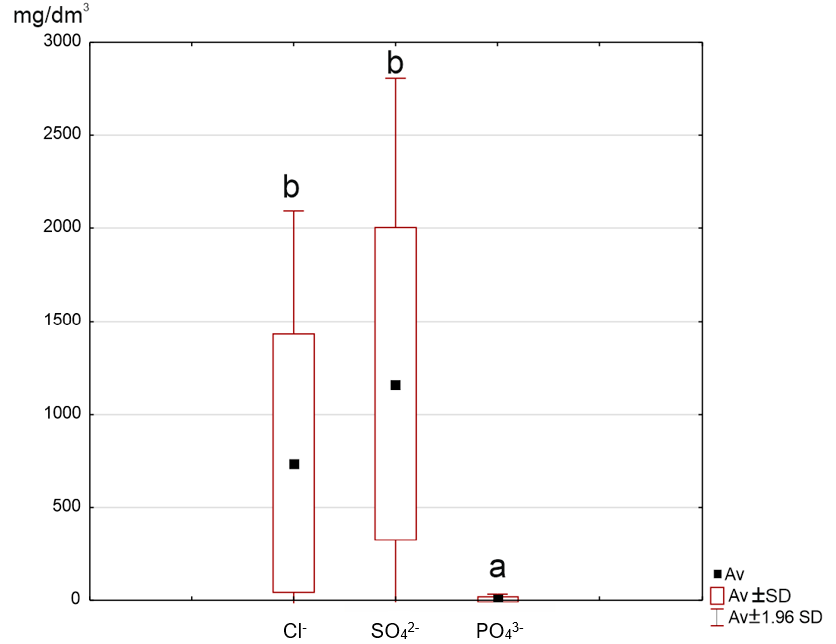
Figure 2. Boxplot for anions in ashes. Means marked with the same letter do not differ at p = 0.05. Cluster analysis was performed for Cl − , SO 42 − and PO 43 − concentrations, which allowed for separating data clusters and visualising correlations between them. Ward’s minimum variance method was used, as it merges the data analysed and distinguishes clusters with minimum variance. The analysis of individual anion groups demonstrated a strong correlation between sulphate and chloride anions ( r 2 = 0.43), which was over 20 times stronger than the correlation between these two anions and phosphates (Figure 3A).